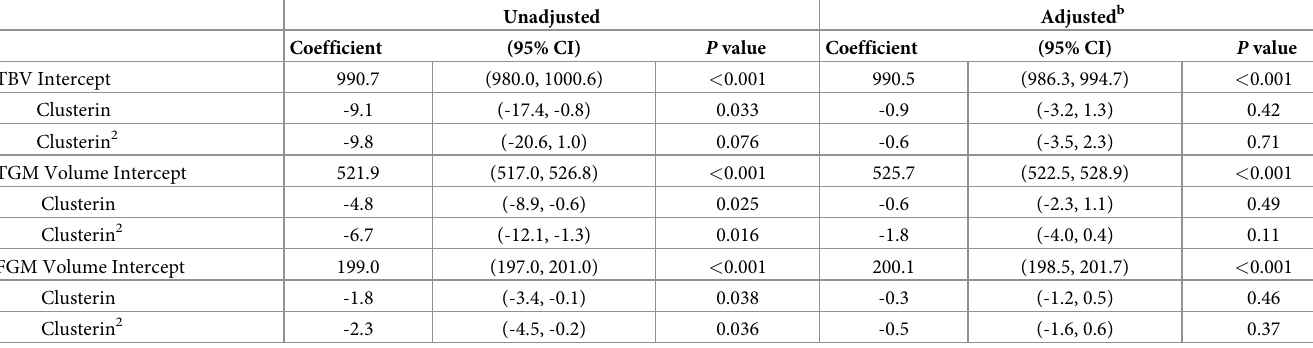
Table 4. Associations of plasma clusterin and MRI volumes for larger brain regions a .